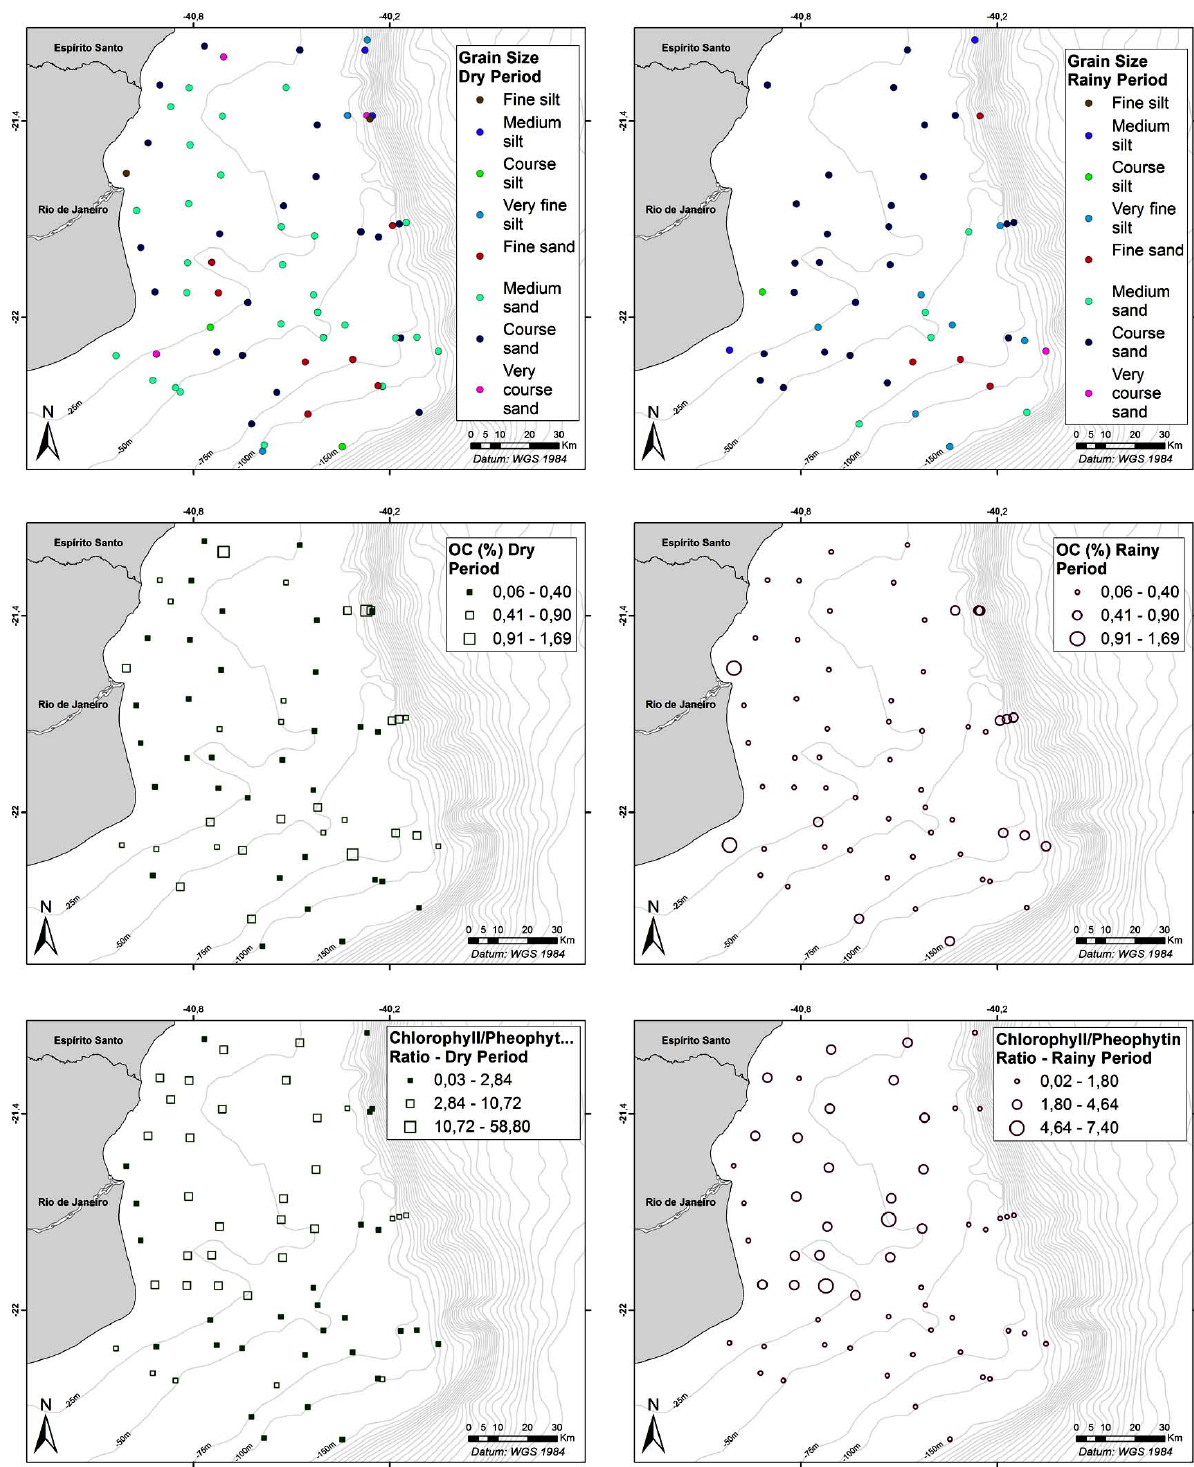
Fig. 3. – The mean grain size distribution, organic carbon (OC) values and chlorophyll/pheophytin ratio at the 53 stations located on the south- east continental shelf of Brazil (A, grain size, dry period; B, grain size, rainy period; C, OC, dry period; D, OC, rainy period; E, chlorophyll/ pheophytin ratio, dry period; F, chlorophyll/pheophytin ratio, rainy